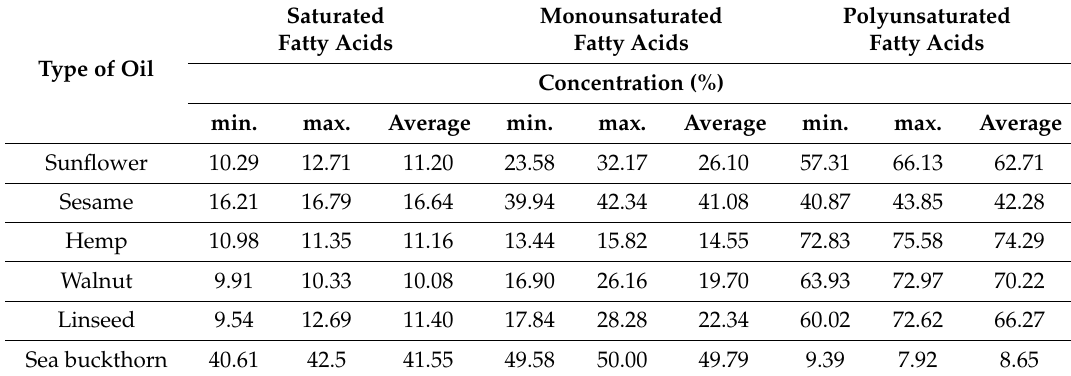
Table 1. Composition of fatty acids (%) grouped by degree of saturation in oil